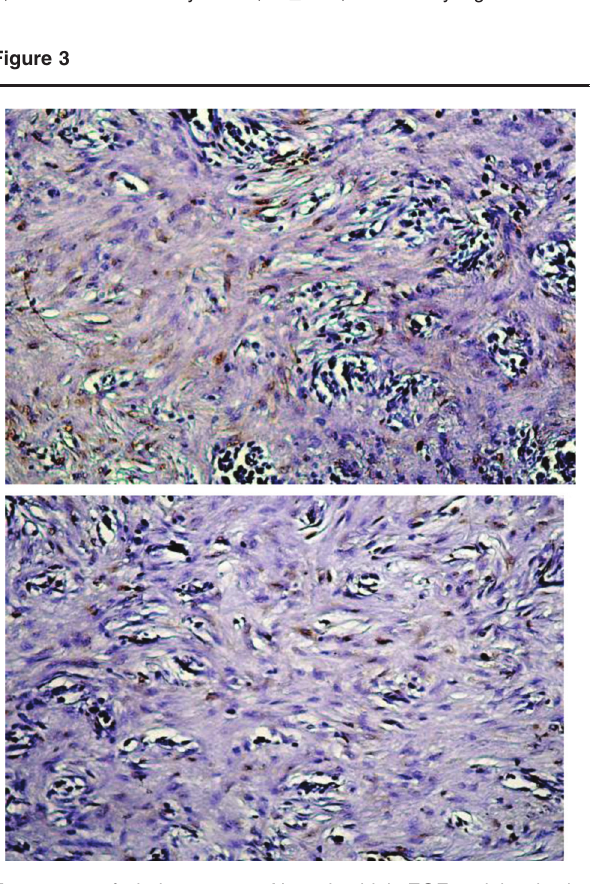
Two cases of cholesteatoma. Note the high EGF staining in the prematrix of cholesteatoma in (upper) children as compared to (lower) adults. (EGF monoclonal antibody, streptavidin-peroxidase technique,